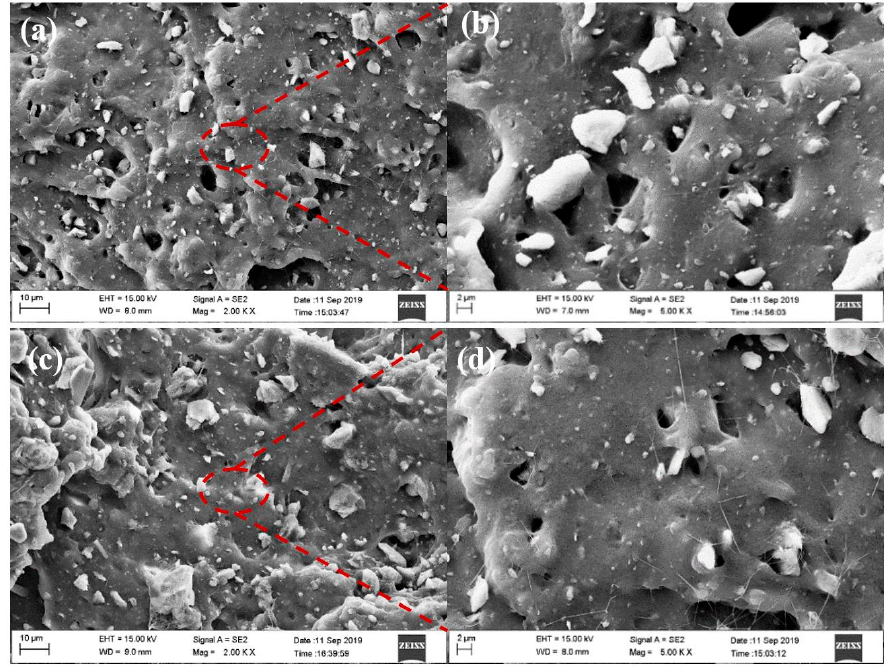
Figure 7. ( a , b ) SEM images of unmodified zeolite/natural rubber ( c , d ) Octadecylamine-modified zeolite/natural rubber.